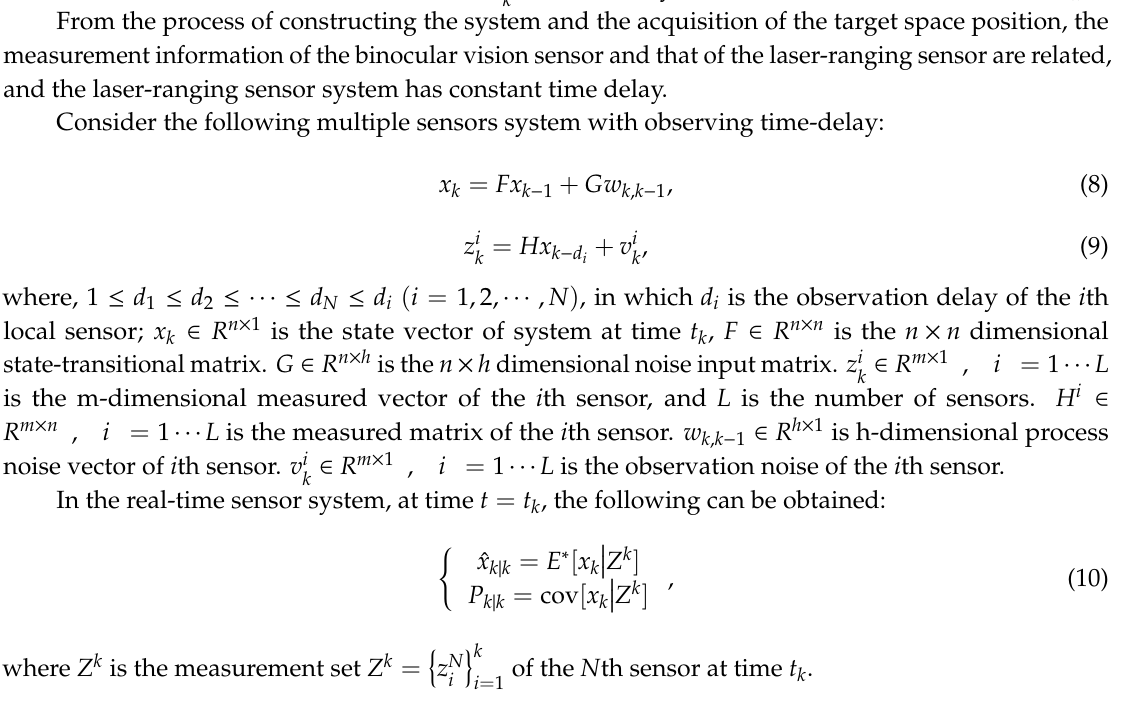
t − . Then, the yaw 1 k